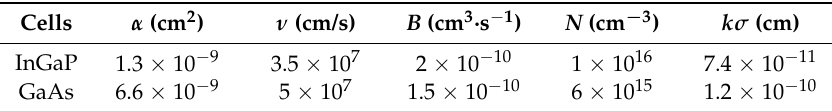
Table 2. Values of α , ν , B , N , and k σ for 5.1 MeV alpha-particle irradiation in the InGaP and GaAs